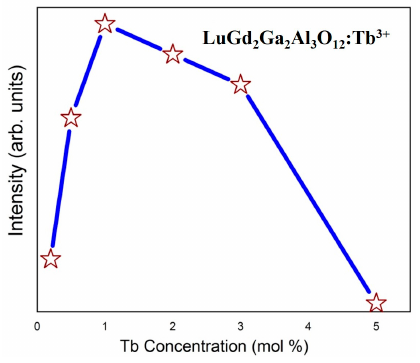
Figure 7. Optimization of Tb 3 + concentrations in LuGd 2 Ga 2 Al 3 O 12 host.